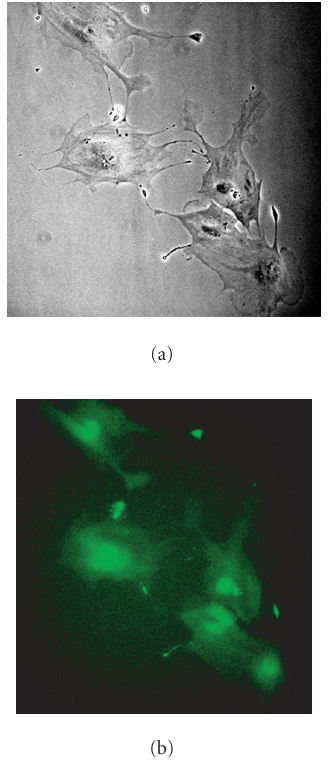
Figure 3. FACS-isolated NCC in cell culture. EGFP-labeled cra- nial NCC were isolated by FACS and established in primary culture as detailed in the “materials and methods.” Photomi- crographs of FACS-isolated, EGFP-labeled NCC (24 hour cul- tures) under brightfield (a) and epifluorescence (b) optics, indi- cate that the cultures contain a viable, homogenous population of EGFP-labeled cells. (Magnification